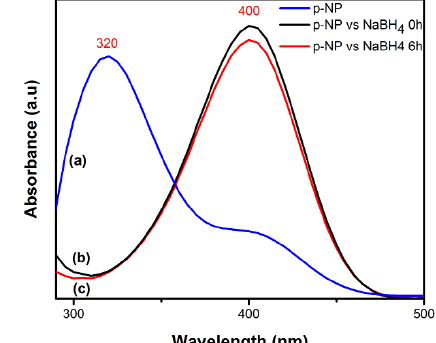
Fig. 6. UV-vis spectra of p-nitrophenol (p-NP) reduction without photocatalysts.